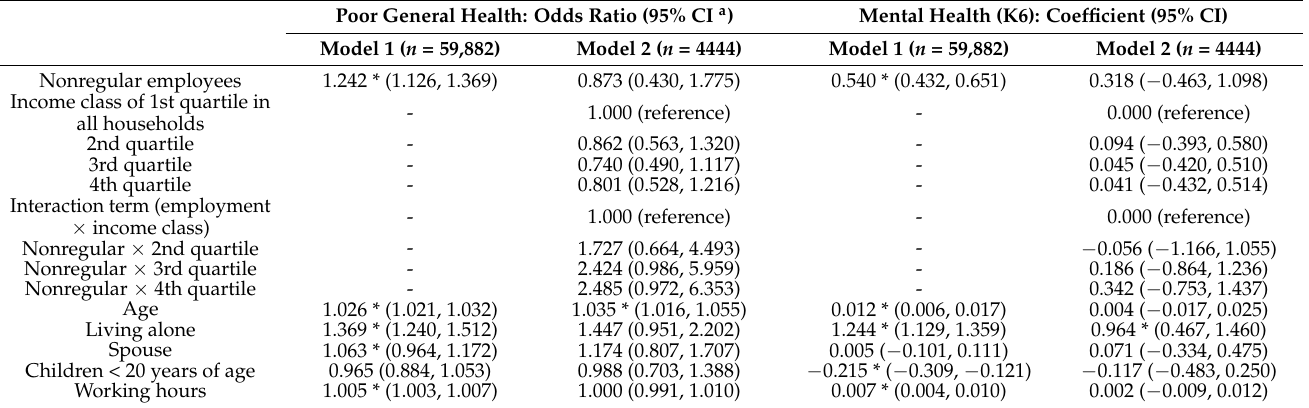
Table 3. Effect of employment, working conditions, and demographic characteristics on health indicators in the regression models for prediction among male workers.